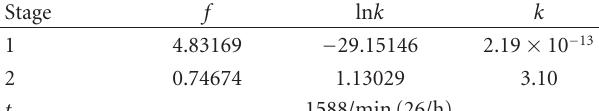
Table 2: Crystallite structure and size of TiO 2 at di ff erent aging time.